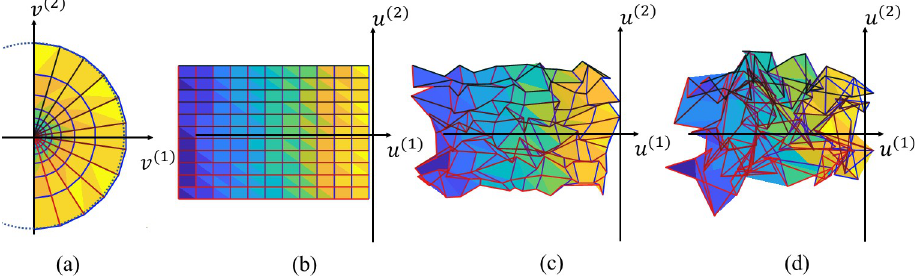
Fig 7. Illustration of the synthetic data. (A) The visual field domain. (B) Mapping without noise. (C) Mapping with a small amount of noise (PSNR = 10). (D) Mapping with a large amount of noise (PSNR =